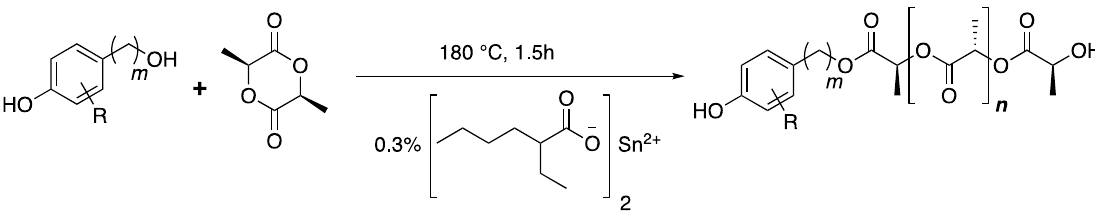
Table 1. Synthesized samples.